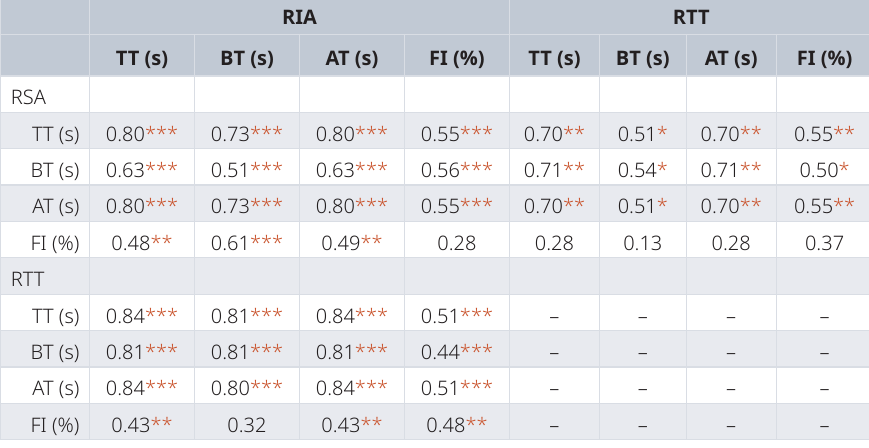
Table 1. Relationship between performance measures of the repeated Illinois agility test (RIA), repeated T-agility test (RTT) and repeated sprint ability (RSA). RIA